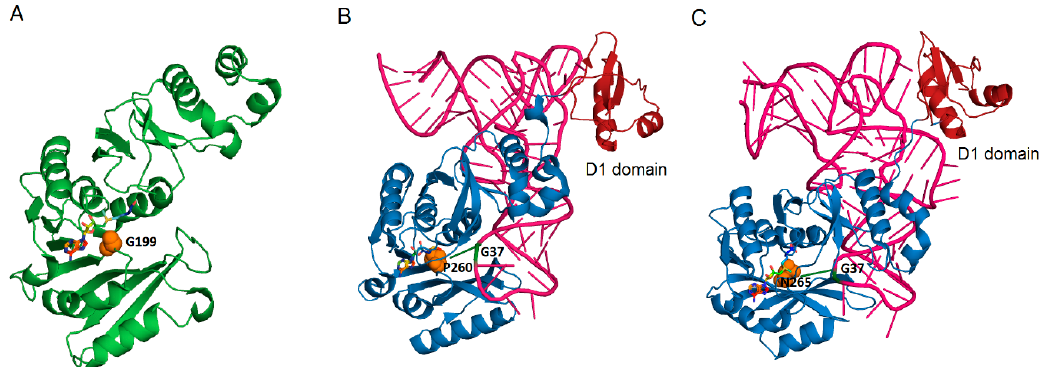
Figure 2. Crystal structures of Taw2, Trm5a = Taw22 and Trm5b. ( A ) Structure of P. horikoshii Taw2 in complex with S-adenosine-L-methionine (SAM) (PDB 3A25). SAM is depicted as rainbow sticks. Critical G199 residue (corresponding to N265 in M. jannaschii Trm5b) is depicted as an orange sphere. ( B ) Structure of P.abyssi Trm5a=Taw22 in complex with MTA (5 ′ -methylthioadenosine) and tRNA Phe (PDB 5WT3). D1 domain of Trm5a is shown in red, and the rest of the protein—in blue. Critical P260 residue (corresponding to N265 in M. jannaschii Trm5b) is depicted as an orange sphere. Transfer RNA is shown in magenta, except for G37 that is shown in green. MTA is depicted as the rainbow sticks. ( C ) M. jannaschii Trm5b structure in complex with SAM and tRNA Leu (PDB 2ZZM). D1 domain of Trm5b is shown in red, and the rest of protein—in blue. Critical N265 residue is depicted as an orange sphere. Transfer RNA is shown in magenta, except for G37 that is shown in green. SAM is depicted as the rainbow sticks. 3.3. Formation of imG2 by Taw21/Taw22 (aTrm5) Enzymes Isowyosine (imG2), together with 7-methylwyosine (mimG), are archaea-unique wyosine derivatives that are present in Thermococalles and several Crenarchaeota ([2,18] and references therein). It has been suggested that imG2 is the likely intermediate of mimG biosynthesis ([2,47], Figure 1). The occurrence of imG2 in different Archaea strictly correlates with the presence of archaeal Trm5a ([2] and references therein). As described above, the Archaeal Trm5a family is characterized by the absence (in many cases) of the D1 domain that is present in the Trm5b/c family of methyltransferases, responsible for the conversion of guanosine into 1-methylguanosine [27]. In some Archaea, like Thermoproteales order of Crenarchaeota, and nanoarchaeon Nanoarchaeum equitans , Trm5a is the only enzyme of the Trm5 family present, suggesting that it catalyzes the formation of not only imG2 but also of m 1 G. Indeed, it was demonstrated that recombinant Trm5a of N. equitans catalyzes the formation of both m 1 G and imG2. Based on these findings, we proposed to rename such dual-specificity Trm5a proteins into Taw22 ([2,27] Scheme 1). In addition to the formation of m 1 G in tRNA Phe , this enzyme is probably responsible for the formation of such modification in other tRNA species of N. equitans . A different situation exists in some Crenarchaeota, like Desulforococcales and Sulfolobales, where Trm5c is present alongside Trm5a and likely corresponds for the formation of m 1 G [2], whereas Trm5a is responsible for the formation of imG2. Indeed, we have demonstrated that Trm5a of Sulfolobus solfataricus catalyzes the formation of imG2, but not of m 1 G [27]. Based on these results, it was proposed to rename the monofunctional Trm5a enzymes into Taw21. The situation is even more complicated in the Thermococcales order of Euryarchaeota. Here, Trm5b is present alongside the Trm5a. We have demonstrated that the Trm5a enzyme of P. abyssi catalyzes the formation of both imG2 and m 1 G in tRNA Phe, but not in tRNA Asp [18,27]. We conclude that in this organism, Taw22 acts on tRNA Phe , whereas Trm5b is responsible for the methylation of G37 in other m 1 G-containing tRNAs. Several crystal structures of PaTrm5a=Taw22 with different cofactors and/or tRNA substrates were obtained (PDB 5HJJ, 5HJI, 5HJK, 5HJM, 5WT1, 5WT3) [48,49]. Structures of PaTrm5a without the tRNA substrate demonstrated an extended conformation (“open” state) compared to the well- folded MjTrm5b. Fluorescence resonance energy transfer (FRET) experiments demonstrated that